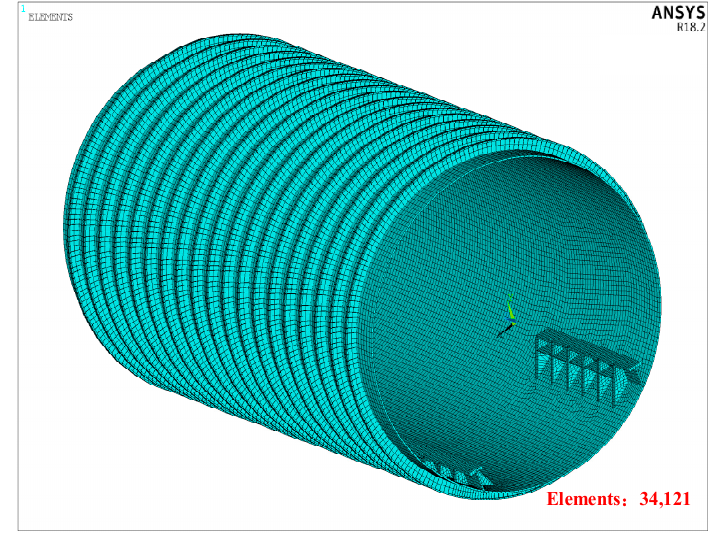
Figure 8. The mesh model of the base with the shell of the underwater vehicle.